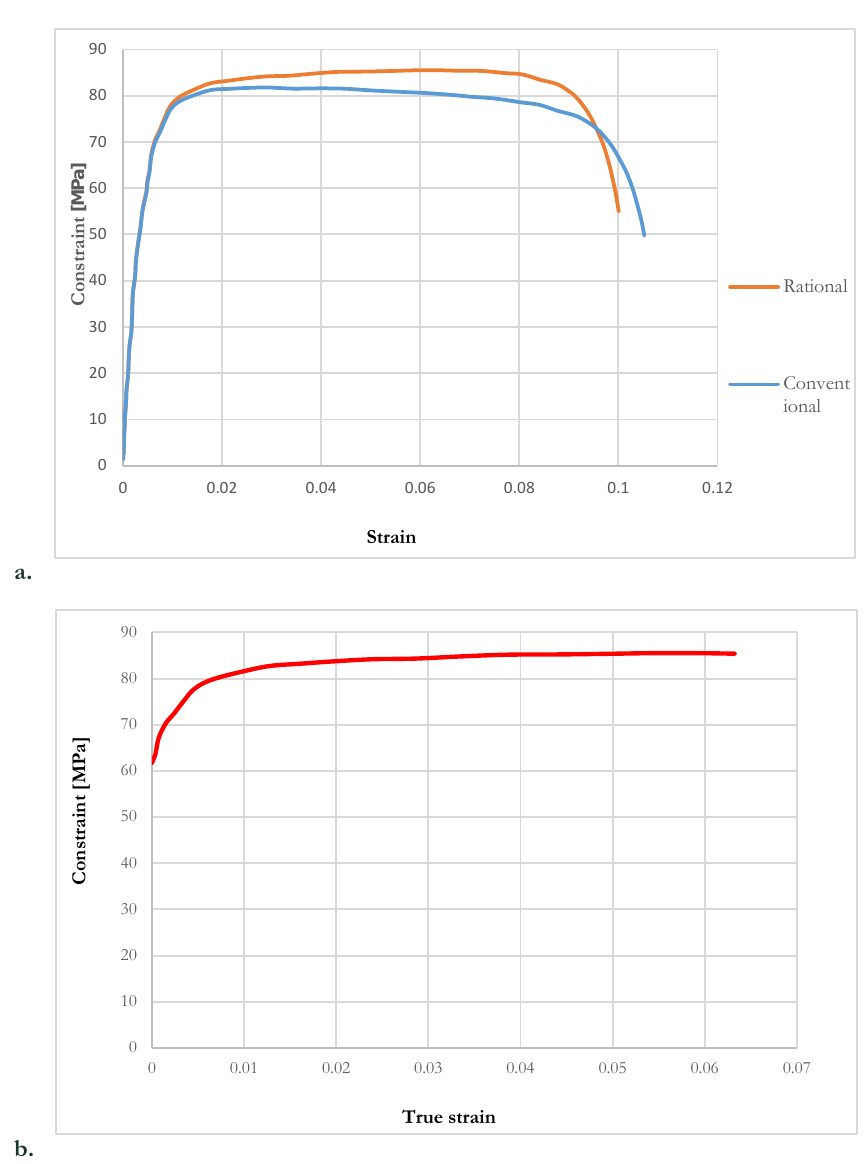
Fig. 2. Characterization of 1050 A aluminum; a. conventional and rational curve, b. flow curve.